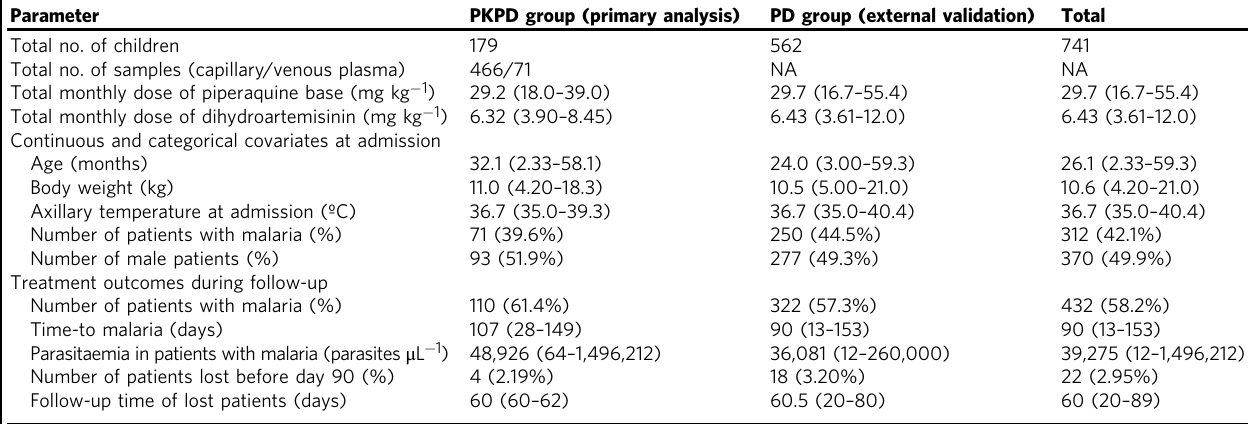
Table 1 Clinical study demographics, sample collection, and treatment outcomes Parameter PKPD group (primary analysis) PD group (external validation) Total no. of children